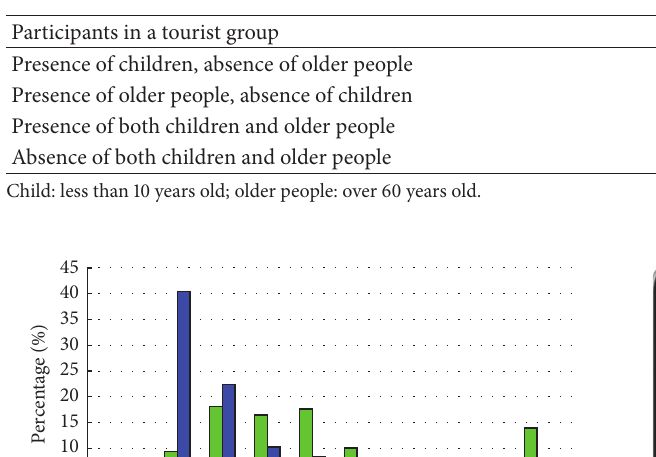
Table 2: Distribution of children and older people in tourist group.